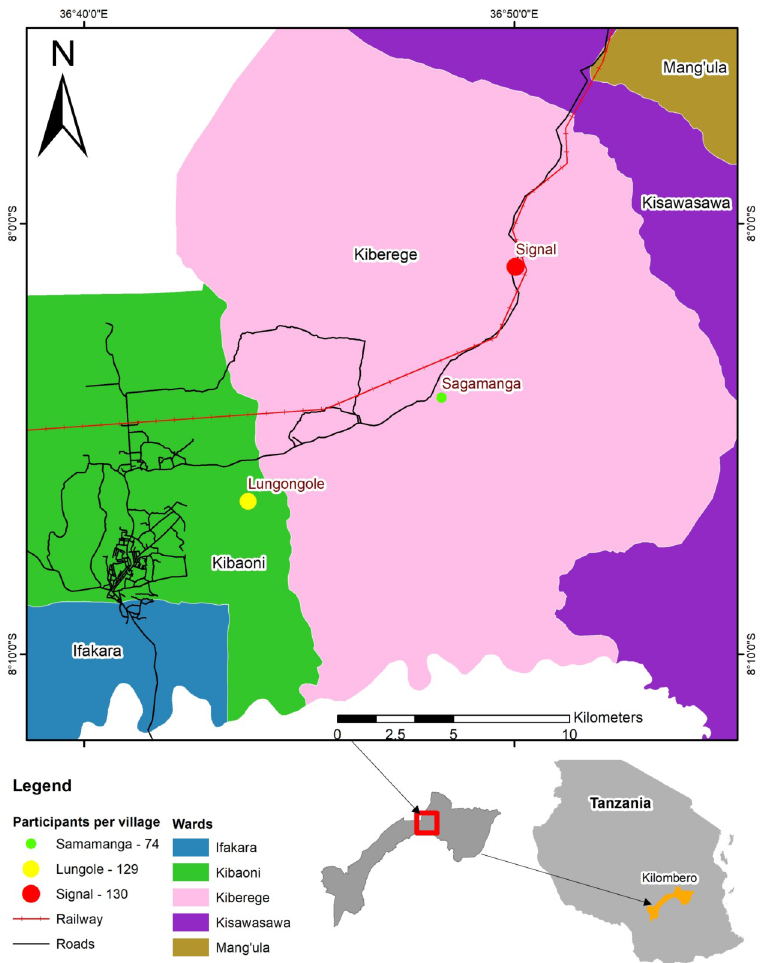
Fig 1. Map of the Morogoro region indicating the three study villages where knowledge, attitudes and practices of agro-pastoralist communities were investigated. while the Wamaasai and Wamang’ati are mainly livestock keepers, farming only on a small scale if at all. These communities have continued to immigrate into this area in the last two decades in search of pasture and water for their livestock. While they keep sheep, goats and cat- tle, the latter are the most valued because of their greater economic value. These livestock keep- ers settled at the fringes of the existing farming villages from where they can easily access the communal grazing grounds located on the margins of the villages. The majority has no formal education, although this is changing and younger generations attend primary school. Most of these communities live a traditional lifestyle in close proximity to their livestock. They fre- quently self-medicate both livestock and people, using conventional and traditional medicines. Livestock is purchased from each other and from livestock markets spread throughout the dis- trict. Communal grazing grounds have been set aside where herding of cattle is done for most of the year. For about three months each year (March to May), the area is flooded and during that time the cattle are grazed within the homestead and in nearby open fields. This seasonal grazing pattern requires young herdsmen (12–30-year-olds) to live for up to nine months each year in makeshift structures in the communal grazing areas away from the homesteads.